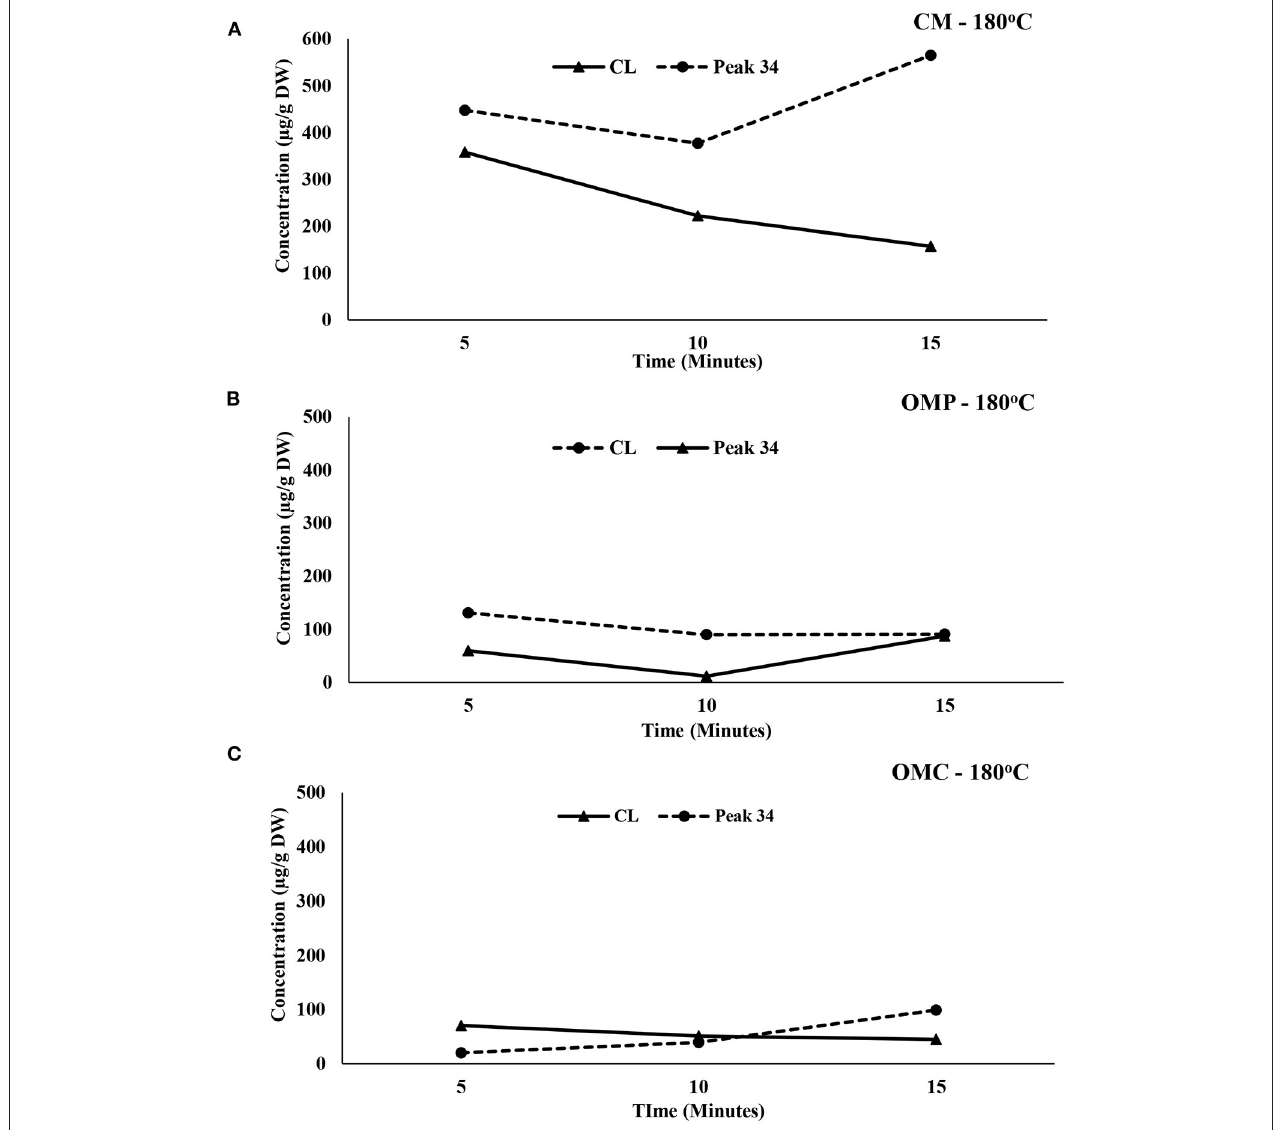
FIGURE 5 | Structure-function relationship of canolol and peak RT-34min for canola meal (A) , oriental mustard powder (OMP) (B) , and oriental mustard cake (OMC) (C) at 180 ◦ C.